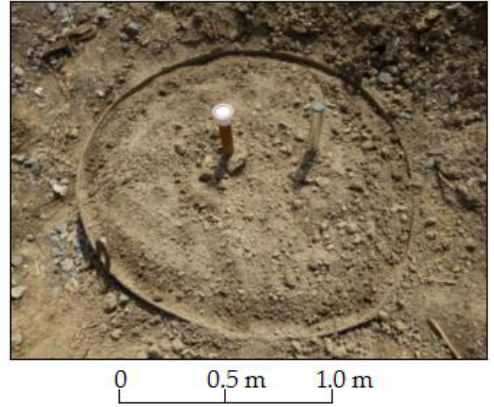
Figure 5. Uncompacted reclaimed soil test barrel.